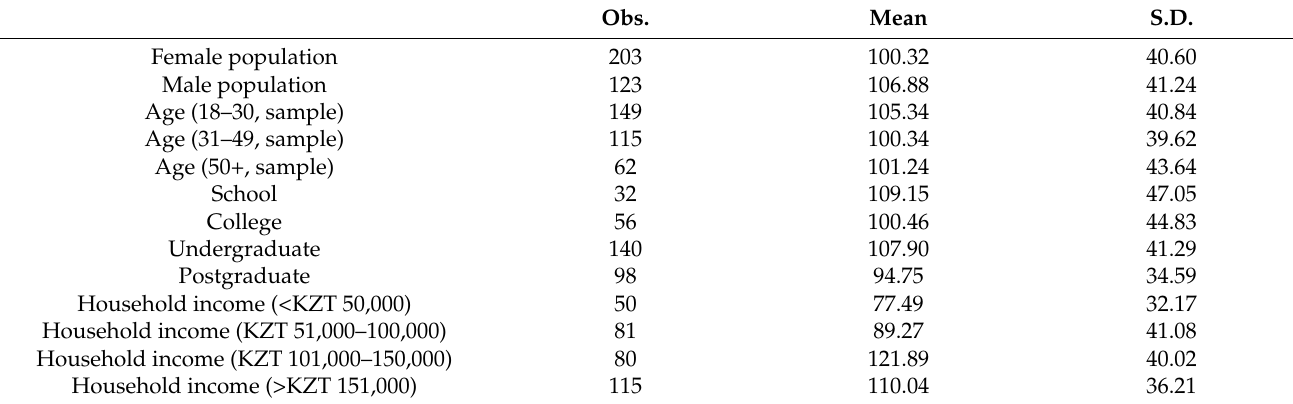
Table 5. The estimated average WTP according to sociodemographic characteristics of the